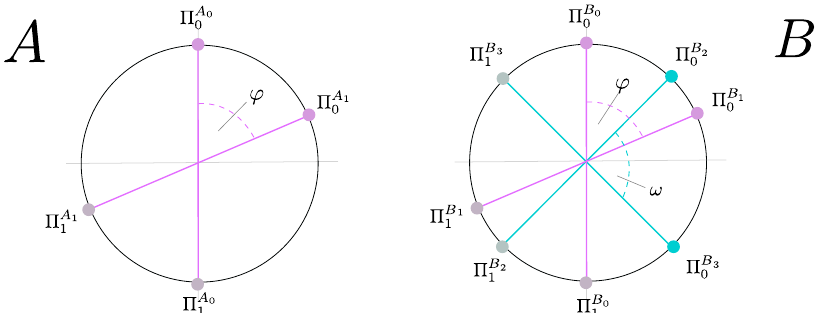
; Π A 0 ; Π A 1 Þ and ð Π A 1 Þ with 1 1 0 0